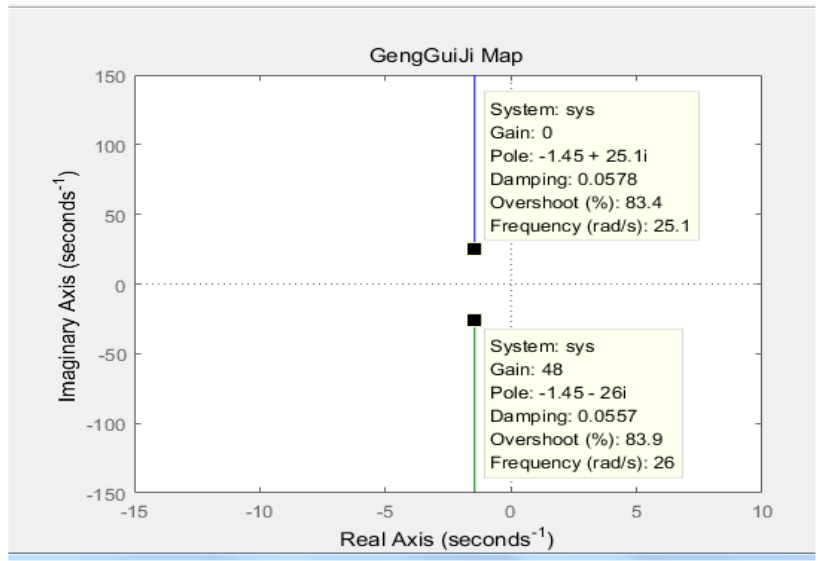
Figure 9. Improved root locus diagram.